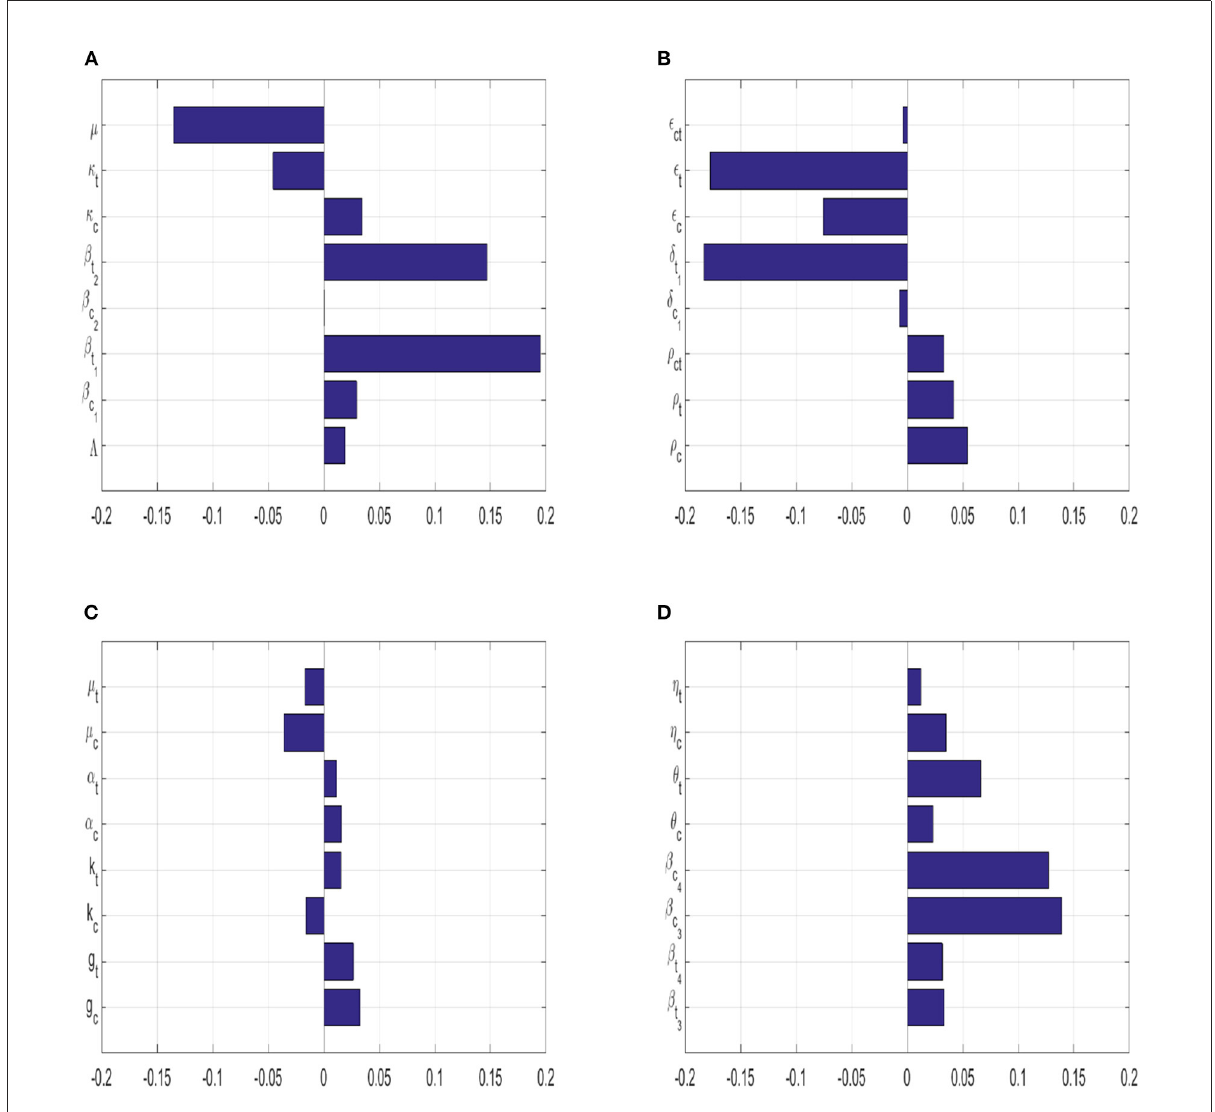
FIGURE2 The correlation between the co-infected class and each of the model’s parameter are shown in this bar graph (PRCC). (A) Shows the PRCC values for { 3 , β